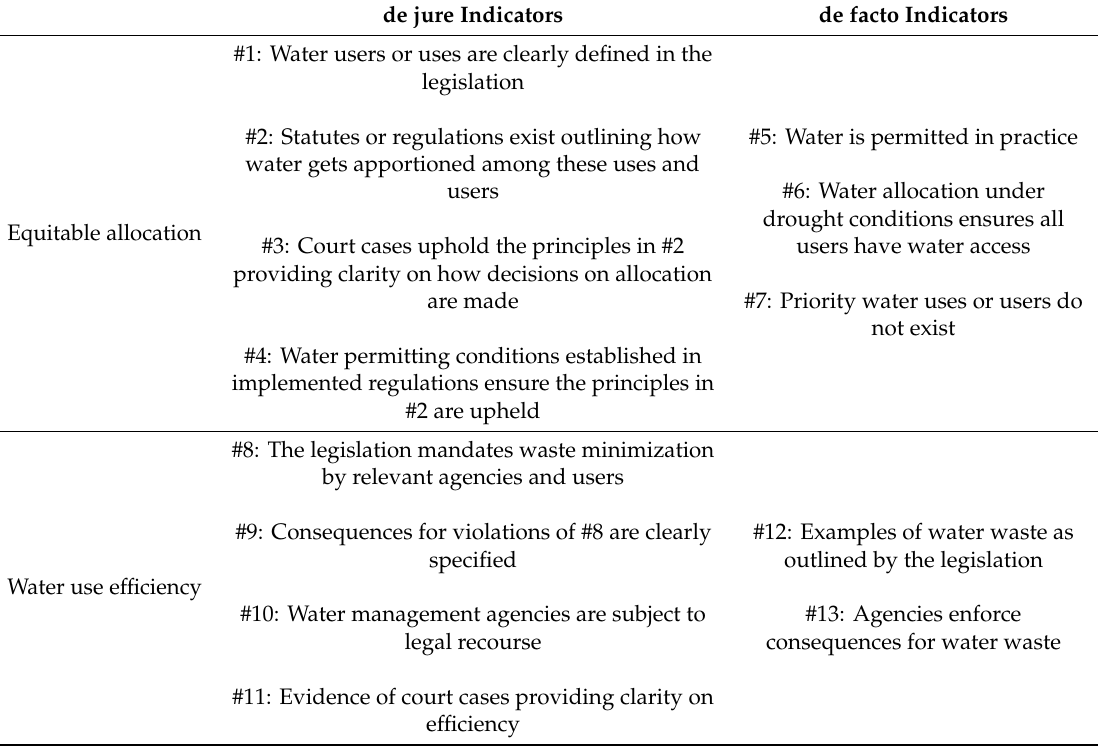
Table 1. Indicators used to determine whether two water governance targets, equitable allocation and water use e ffi ciency, exist in legislation (de jure) and practice (de